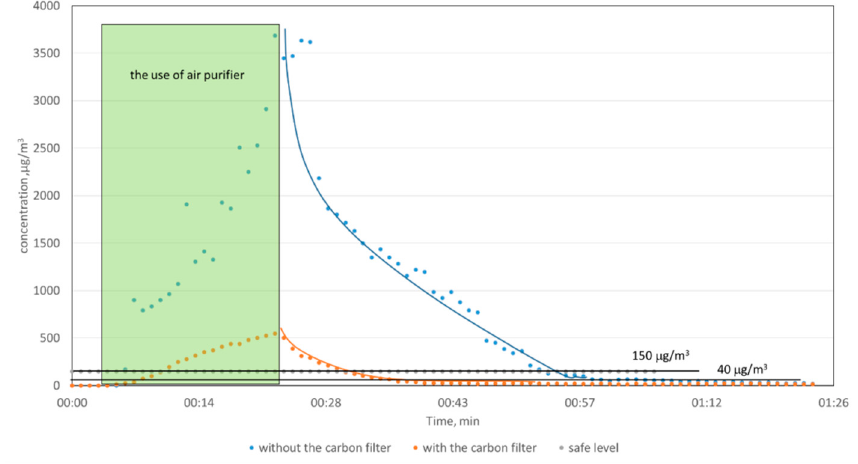
Figure 6. The rate of ozone reduction during the work of air purifier with and without a carbon filter.